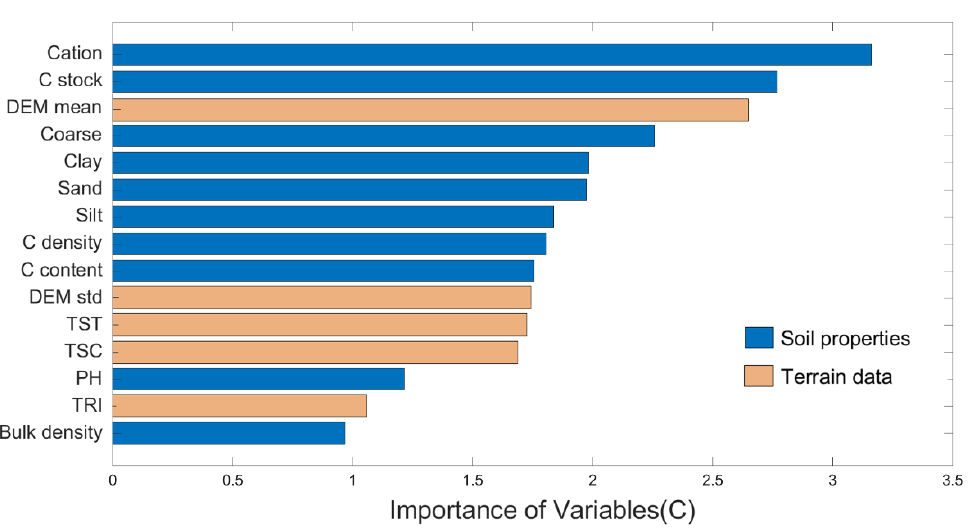
Figure 3. The computation results of the 𝐶 values in 2018. ( a ) Map of the retrieved soil parameters; ( b ) map of the RF predicted 𝐶 soil parameters; ( c ) histograms of the retrieved 𝐶 , and ( d ) scatterplot between the retrieved and RF predicted values for the 𝐶 value.